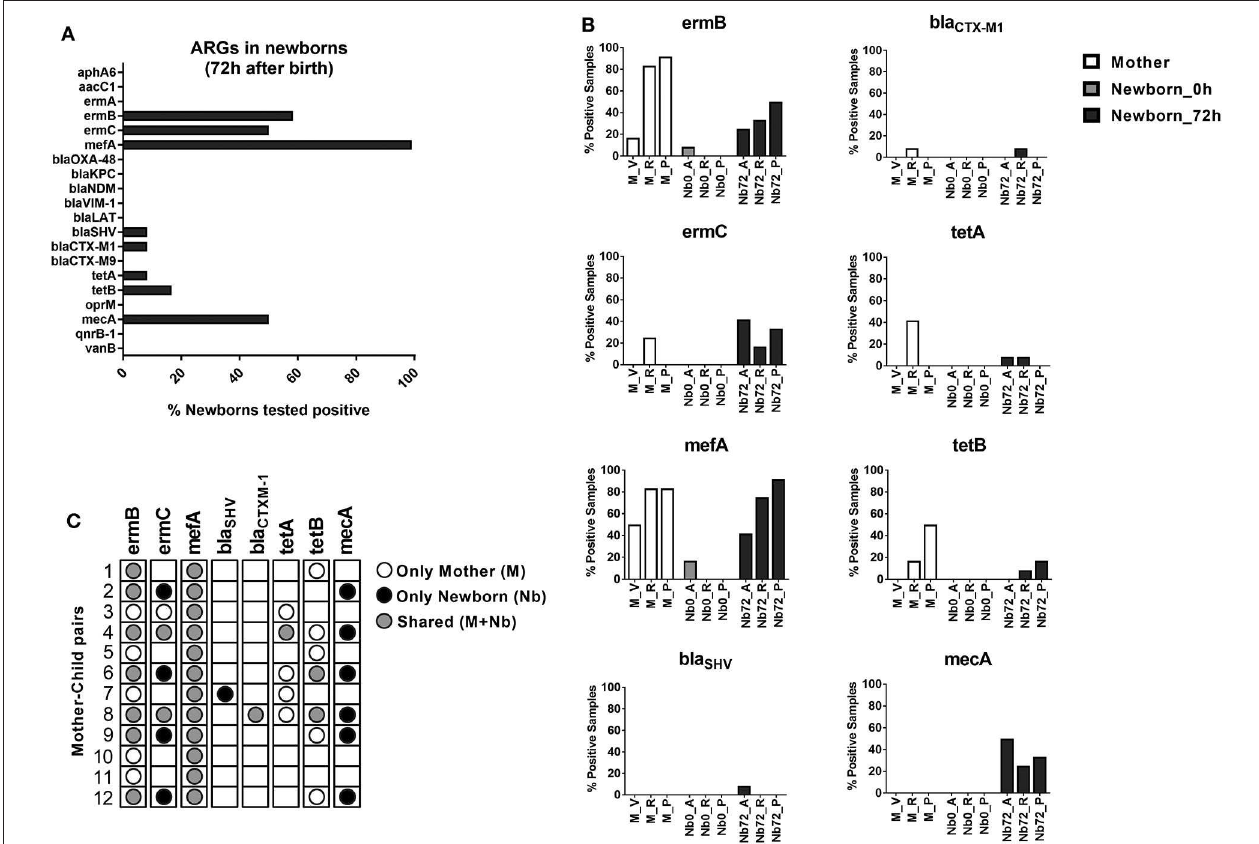
FIGURE 3 | ARG detection in newborns. (A) Bar chart depicting the ARG expression in newborns 72h after birth. Bars represent percentage of newborns with at least one positive sample. (B) Detailed view on the distribution of positively tested ARGs across the different sample sites of mothers and newborns at the time of birth and after 72h (M, mother; Nb0, newborn at time of birth; Nb72, newborn after 72h; V, vagina; A, axilla; R, rectum; P, pharynx). Bars represent the percentage of positive samples in each case. (C) Dot plot showing the presence of ARGs in each mother-child pair, indicating whether the resistance-determinants were detected only in the maternal samples (white circle), only in the newborn samples (black circle) or shared by both (gray